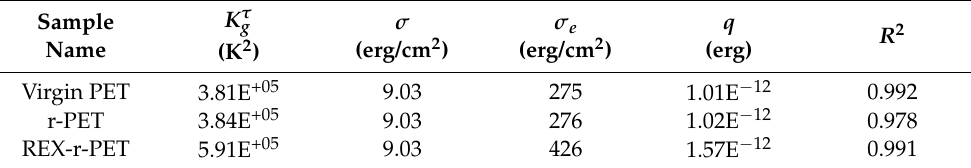
Table 4. Values obtained by fitting the L–H theory to the experimental DSC overall crystallization data. Parameter proportional to the energy barrier for the secondary nucleation ( K τ g ), fold surface energy ( σ e ), and work done by the chain to perform a fold ( q ). R 2 is the correlation coefficient for the fitting of the L–H model Equation